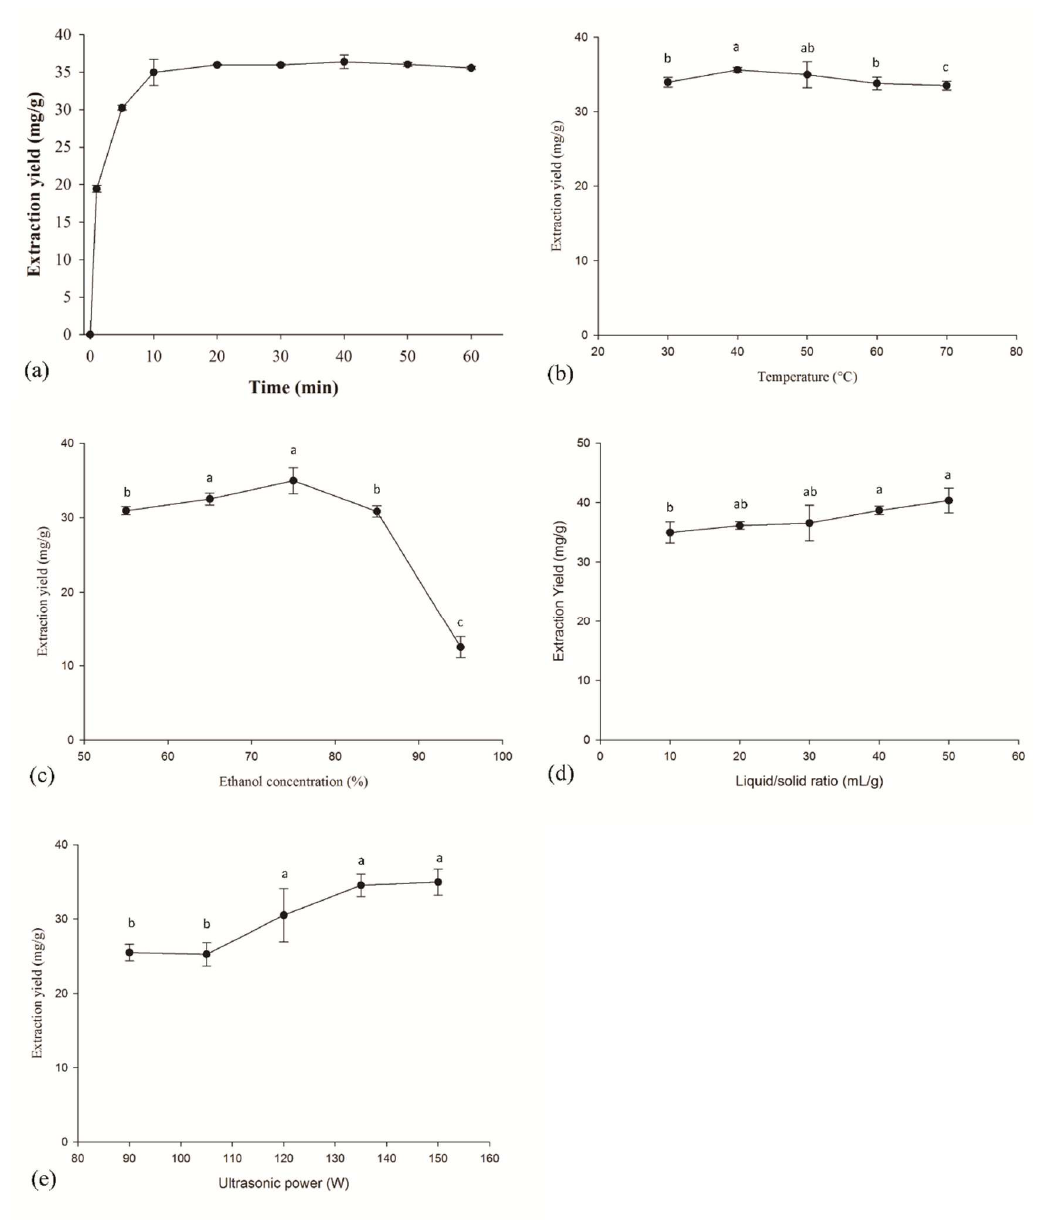
Figure 1. E ff ect of ( a ) time, ( b ) temperature, ( c ) ethanol concentration, ( d ) liquid / solid ratio, and Figure 1. Effect of ( a ) time, ( b ) temperature, ( c ) ethanol concentration, ( d ) liquid/solid ratio, and ( e ) ( e ) ultrasonic power on the yield of CGA. Di ff erent letters a, b, and c indicate significant di ff erences ultrasonic power on the yield of CGA. Different letters a, b, and c indicate significant differences ( p < ( p < 0.05).